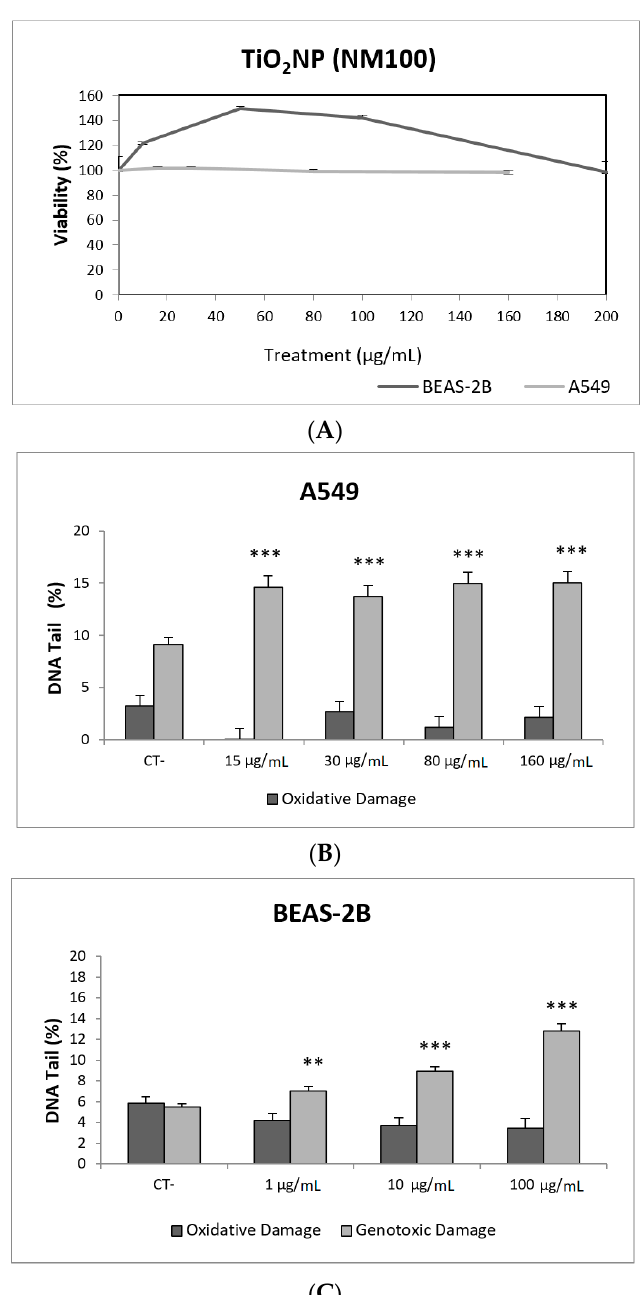
Figure 2. Results from the TiO 2 NPs (NM100) on A549 and BEAS-2B cells. ( A ) Toxicity curves for both cell lines. ( B ) Genotoxicity results obtained in A549 cells. ( C ) Genotoxicity results obtained in BEAS-2B cells. Genotoxicity data are plotted as mean ± SEM of two independent experiments. ** p ≤ 0.01, *** p ≤ 0.001 (one way-ANOVA). CT, control.